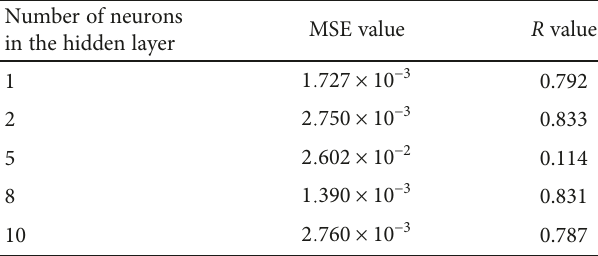
Table 5: Values of MSE and R depending on the number of neurons in the hidden layer in model ANN